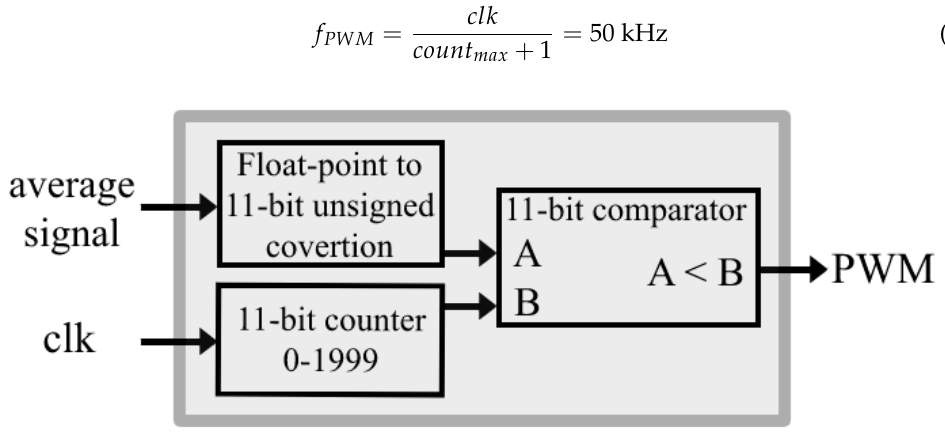
Figure 14. Implementation of an individual PWM module.